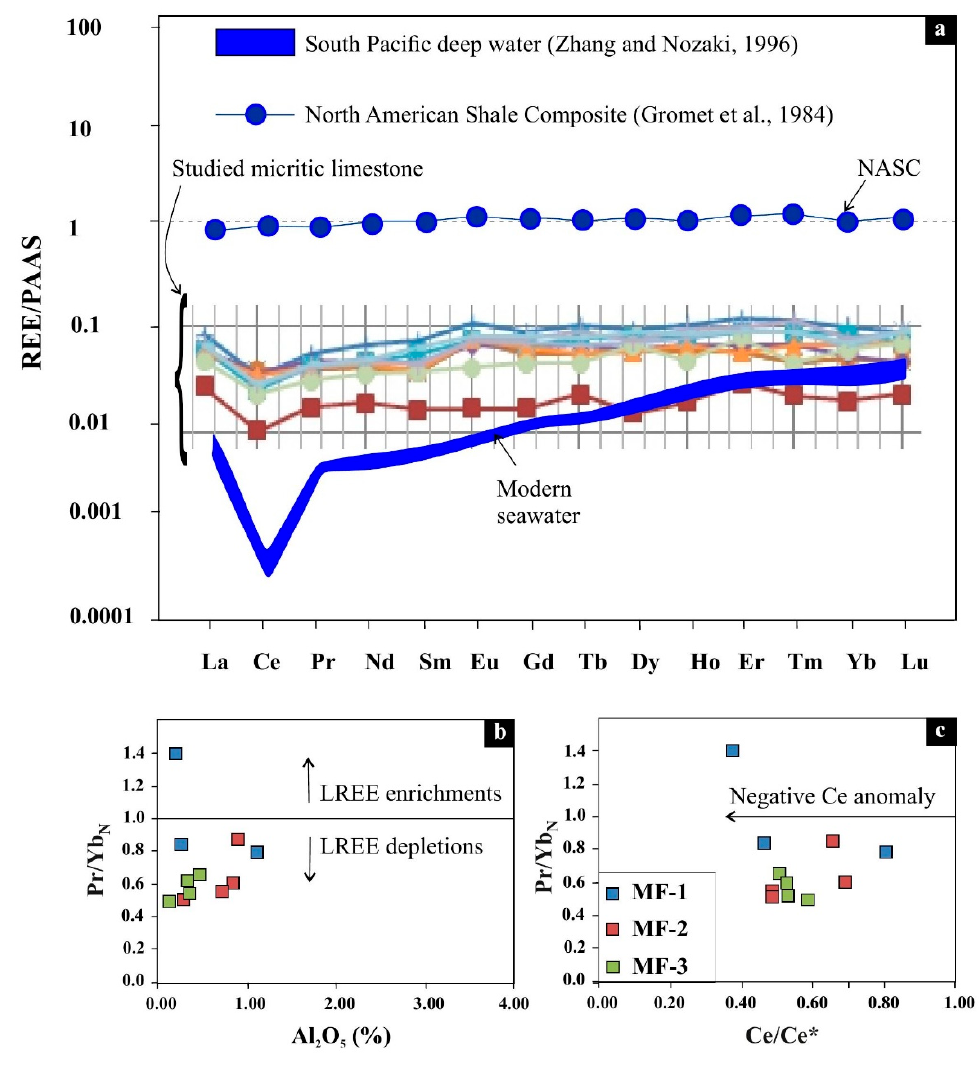
Figure 6. PAAS-normalized REE patterns of the studied limestone succession ( a ). Plot of the Pr / Yb N values vs Al 2 O 3 (wt %) contents ( b ) and Pr / Yb N value vs. Ce / Ce* ratios ( c ). Modern seawater data from South Pacific deep water [11] and North American Shale Composite from [76].